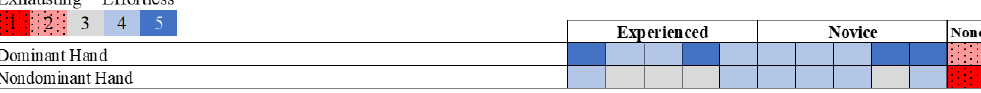
Figure 14. Effort scores separated by participant (n = 11), hand dominance, and video-game experience (experienced, novice, none). The participant without video-game experience found the task to be